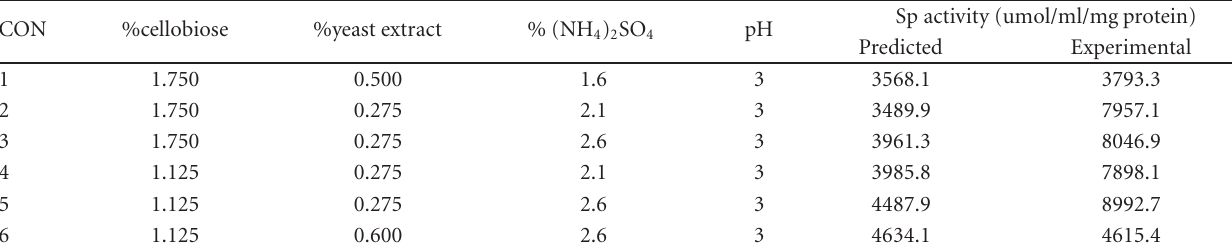
Table 7: Model predicted value for specific activities at optimum